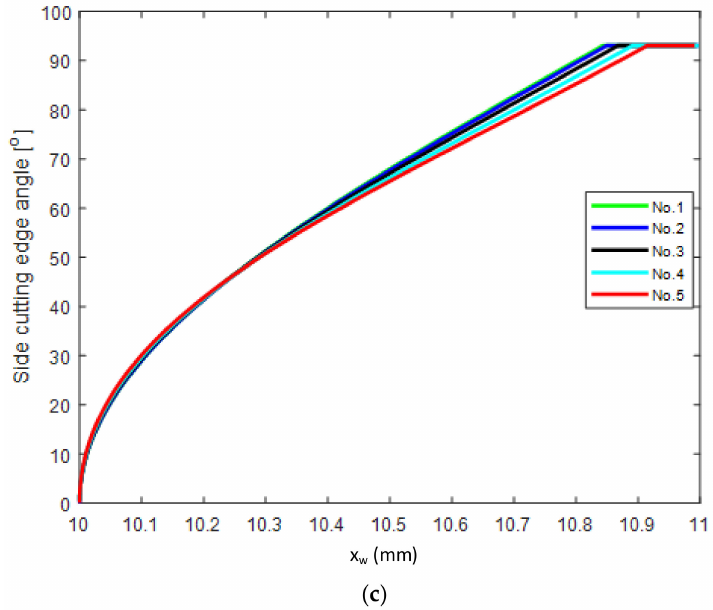
Figure 7. Actual angles along the cutting edge: ( a ) working normal rake angle (NRA); ( b )working inclination angle; ( c ) side cutting edge angle on each